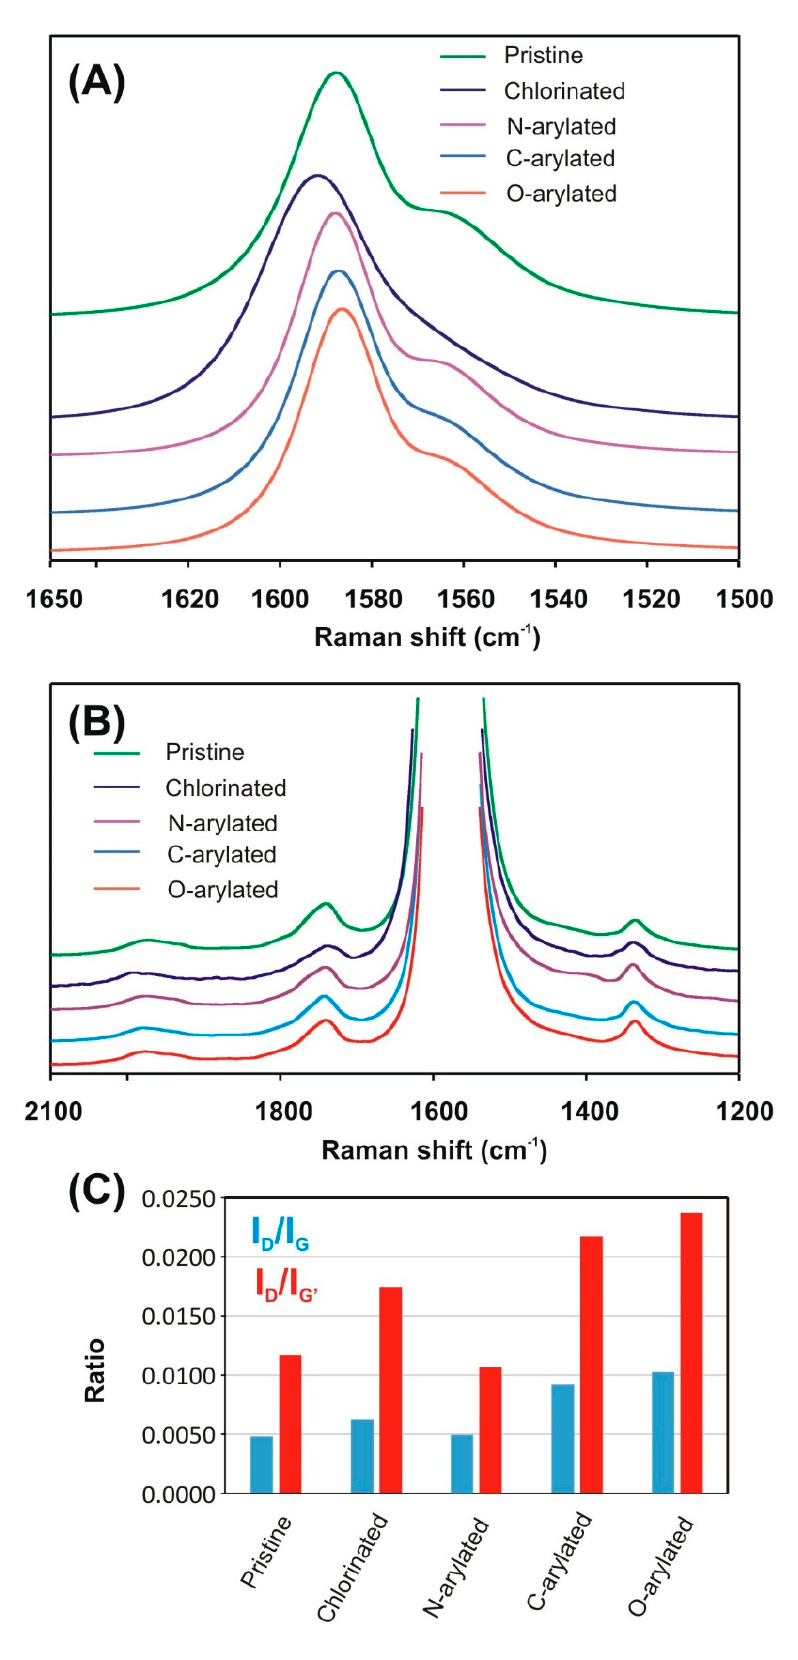
Figure 4. The G-band ( A ) and D-band ( B ) region of SWCNT samples; ( C ) I D / I G and I D / I G’ ratios presented as blue and red bars, respectively.